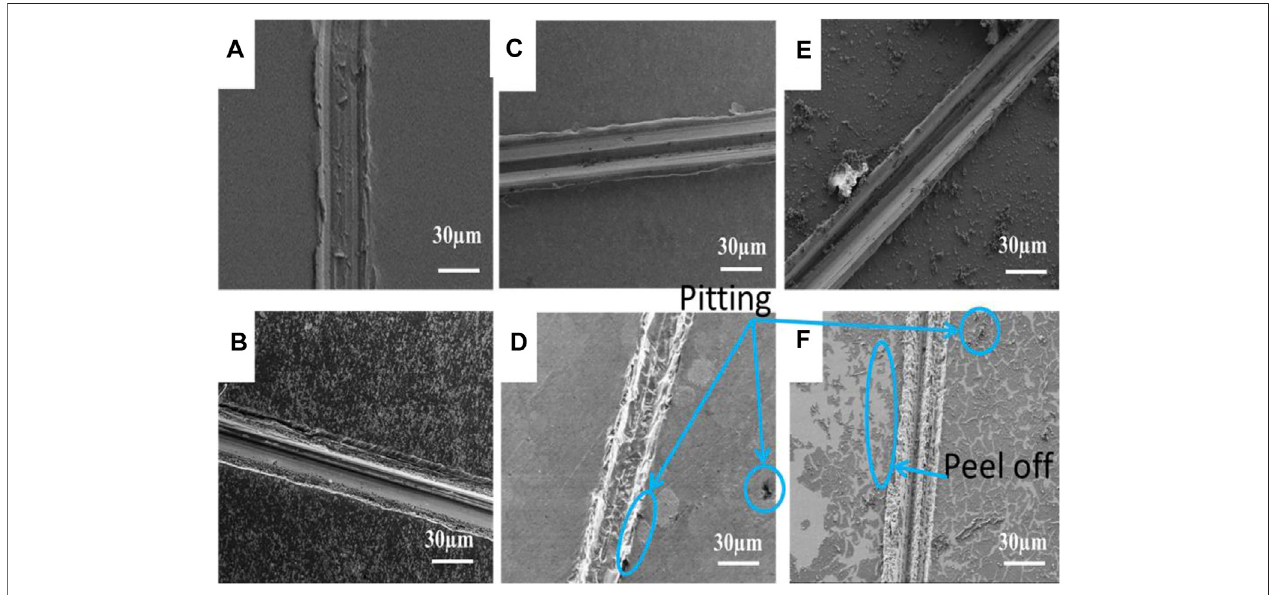
FIGURE7| SEMimagesofthescratchedcoppersurfaces (A) bareCu, (C) 0.02M8-HQ@Cu, (E) PDA@Cu,andthecorrespondingscratchedcoppersurfaces: (B) bare Cu, (D) 0.02M 8-HQ@Cu, and (F) PDA@Cu, taken after immersed in 3.5 wt.% NaCl aqueous solution for 10 h (corrosion time) at 25 ° C.